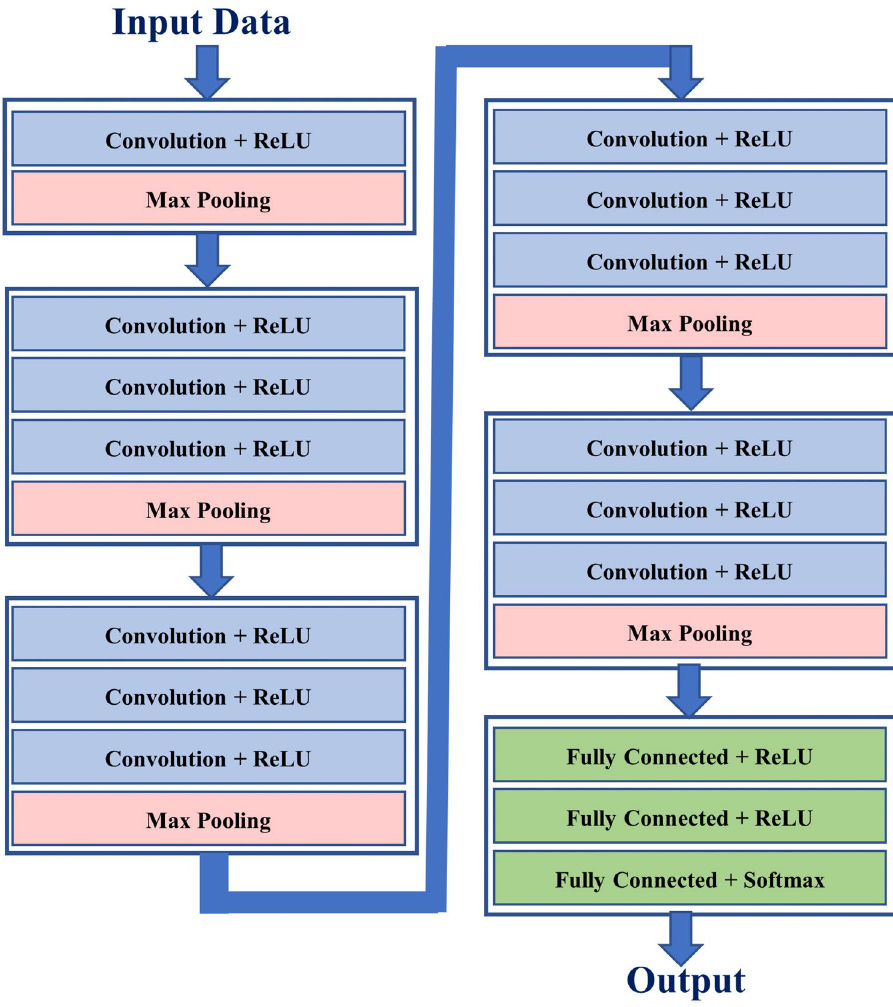
Figure 7. Architectural diagram of the proposed 1-D